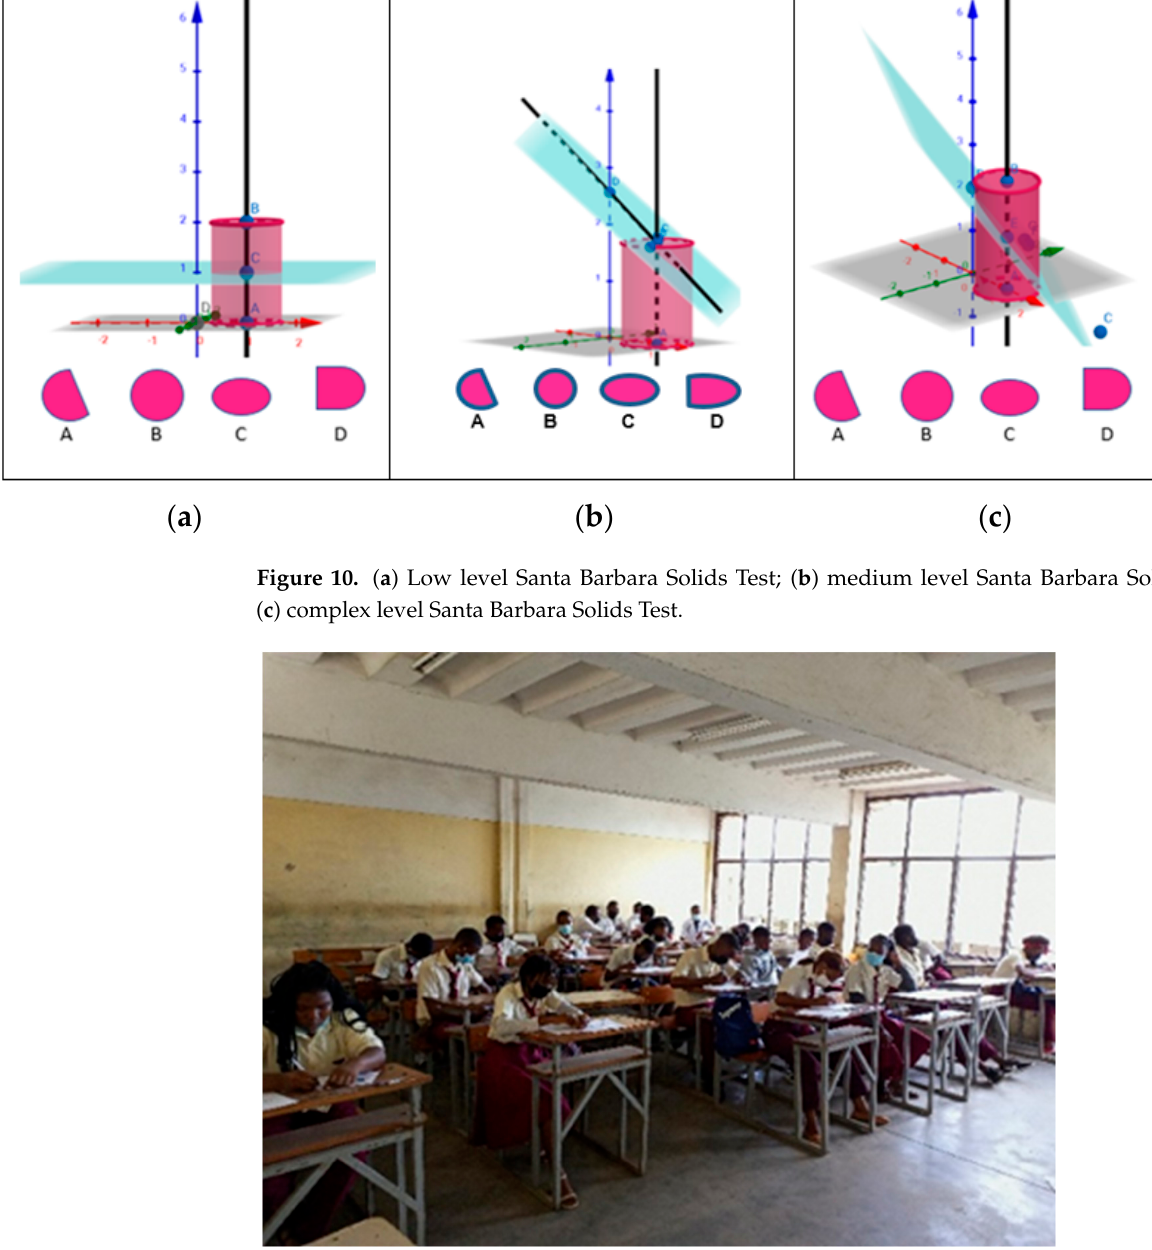
Figure 11. Moment of solving the Santa Barbara Solids Test. Students solving the Santa Barbara Solids Test.